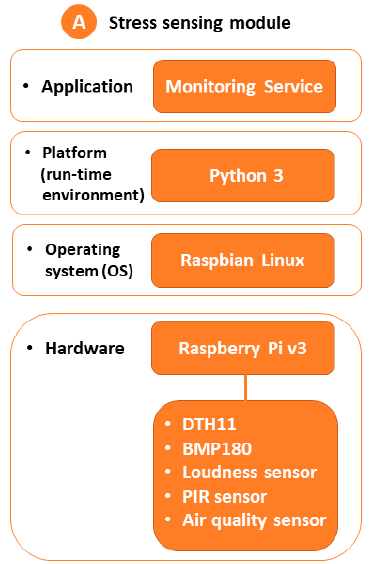
Figure 7. Architecture of stress sensing module.